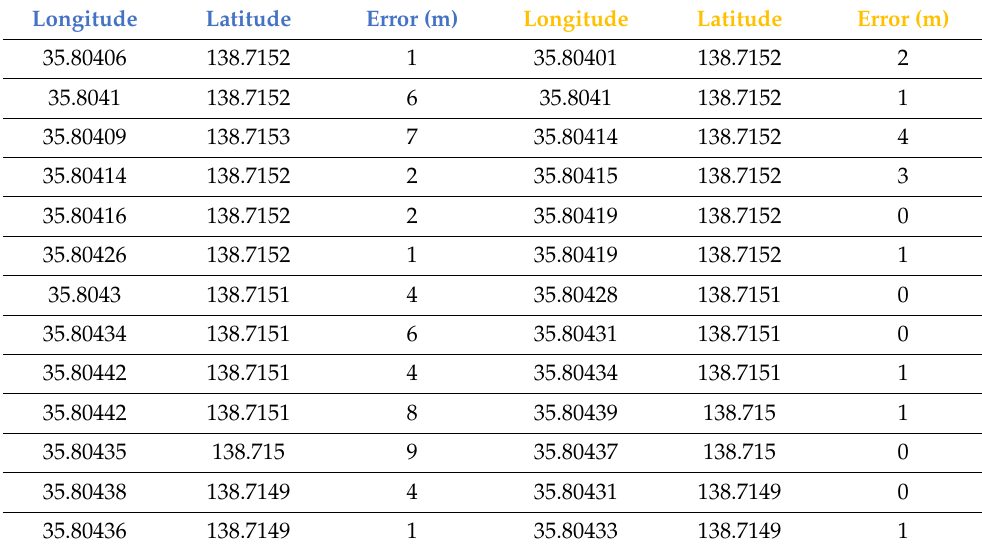
Table 3. Latitude/longitude and error distance (blue: GPS record, yellow: estimated